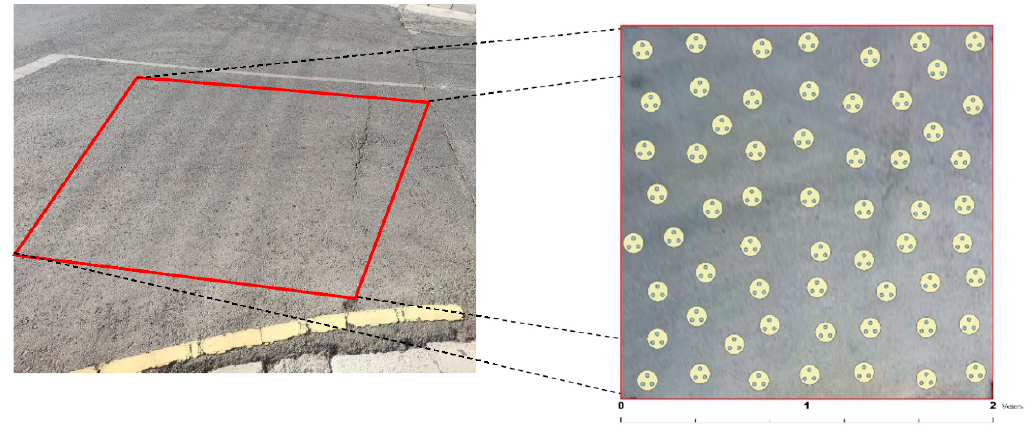
Figure 2. Example of a 4 m 2 road section on the left (in red box). Example of Radiometer (yellow dots) and colorimeter (blue dots) dataset collection on the right (in scale).